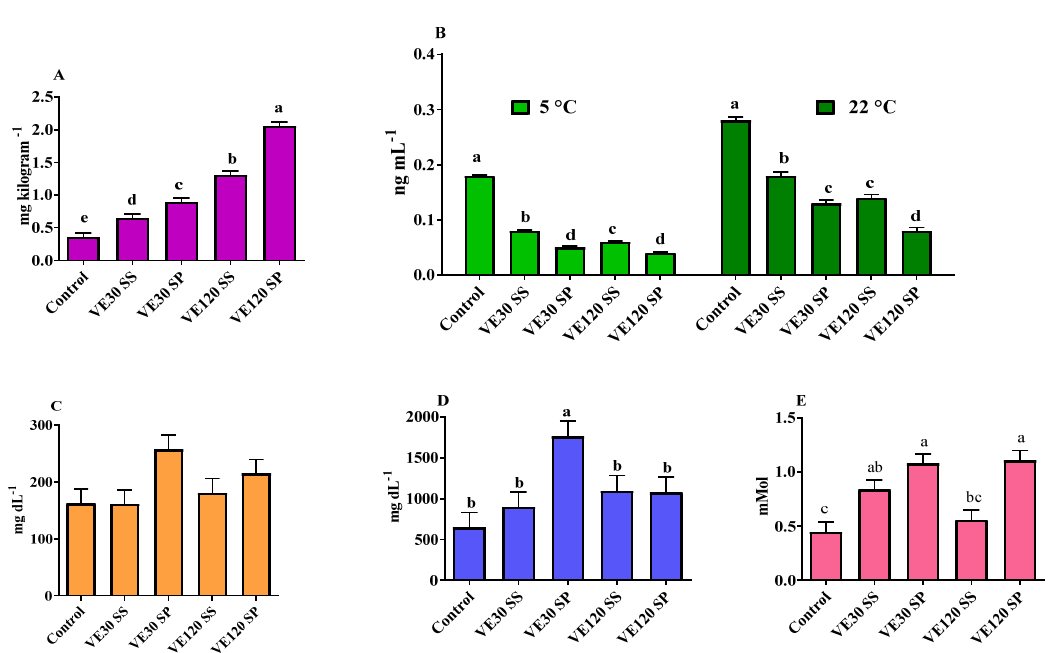
Figure 2. ( A ) egg yolk selenium concentration, ( B ) egg yolk MDA concentration after being stored for 30 days at 5 and 22 °C, ( C ) blood cholesterol concentration, ( D ) blood triacylglycerol concentration and ( E ) blood total antioxidant capacity of Japanese quails fed different levels of vitamin E (VE, 30 or 120 mg kg − 1 ) and Se sources (SS, sodium selenite; SP, Sel-Plex). Values (means ± SEM) with uncommon letters are significantly ( p < 0.05) different in each graph.